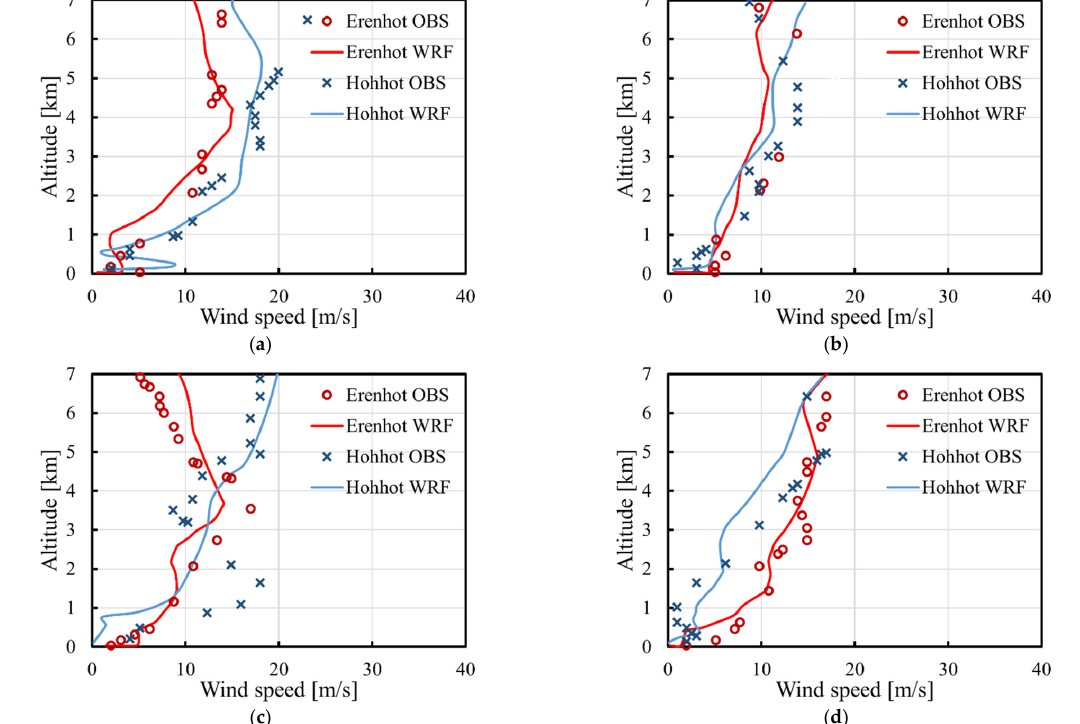
Figure 14. Profiles of the wind speed above the main landing area from WRF and upper-atmosphere sounding data at ( a ) 12:00 LST on 24 June 2013, ( b ) 12:00 LST on 26 June 2013, ( c ) 00:00 LST on 25 June 2013 and ( d ) 00:00 LST on 27 June 2013. With the removal of outliers, Table 6 shows the statistical biases of the mean wind speed. Compared with the above two cases, deviations fluctuate more, showing larger maximum and smaller minimum values. Nevertheless, the average variations are still scattered around zero and have small absolute values. The maximum absolute value of the average deviations in Erenhot is 2.77 m/s at 12:00 LST on 26 June 2013, and in Hohhot it is 2.42 m/s at 00:00 LST on 26 June 2013. At the other moments, the maximum absolute value in both Erenhot and Hohhot does not exceed 2 m/s. It demonstrates the relatively high reliability of the WRF results. Table 6. Statistical biases of mean wind speed above the main landing area in the “Shen Zhou 10” case. Time [LST]